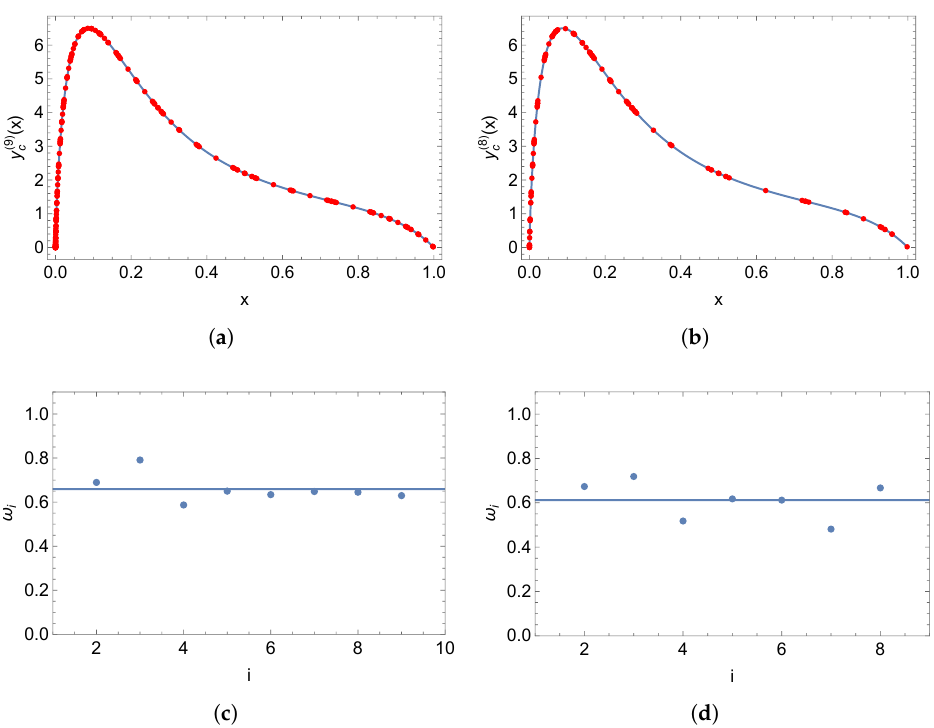
Figure 8. Visualization of the approximating polynomial and statistic ω i . ( a ) Approximating poly- ( 9 ) ( x ) obtained by multiplying Equation (25) by x . ( b ) Approximating polynomial y ( 8 ) nomial y c obtained by y ( x ) − y c ( x ) . ( c ) Plot of ω i , i = 2,3, . . . ,9.